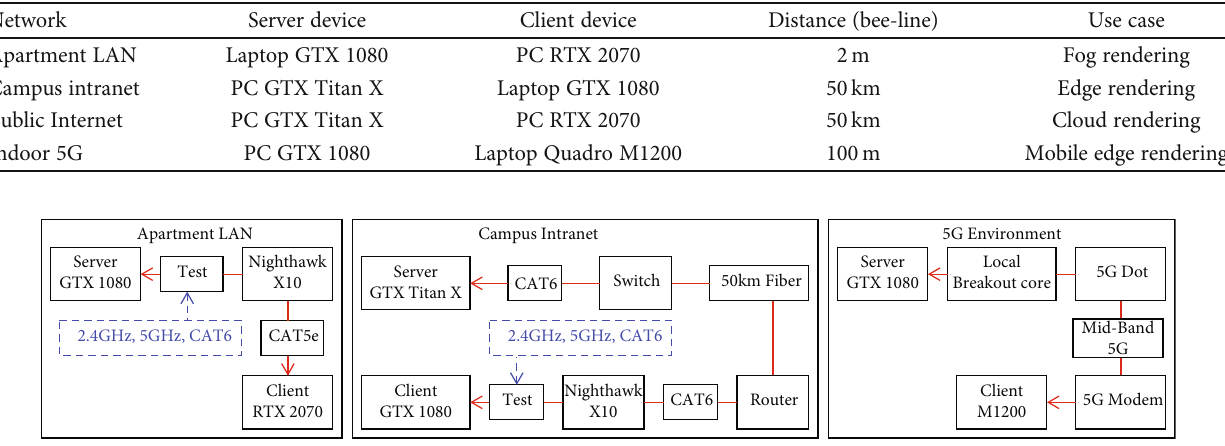
Table 2: Environment